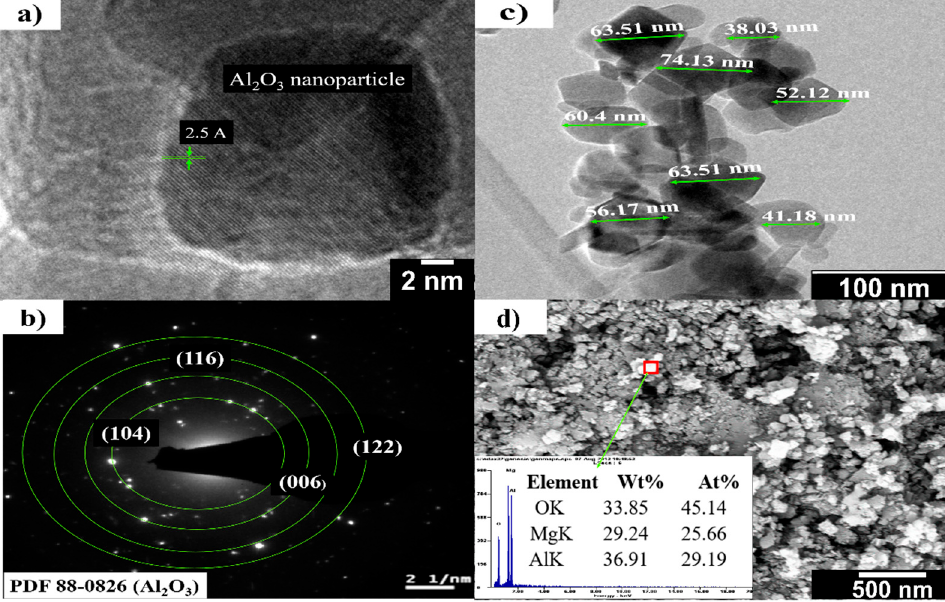
Figure 2. ( a ) TEM image of an α -Al 2 O 3 nanoparticle; ( b ) electron diffraction pattern of an α -Al 2 O 3 nanoparticle; ( c ) TEM image of α -Al 2 O 3 nanoparticles sizes; ( d ) SEM image of α -Al 2 O 3 nanoparticles in MgO matrix.